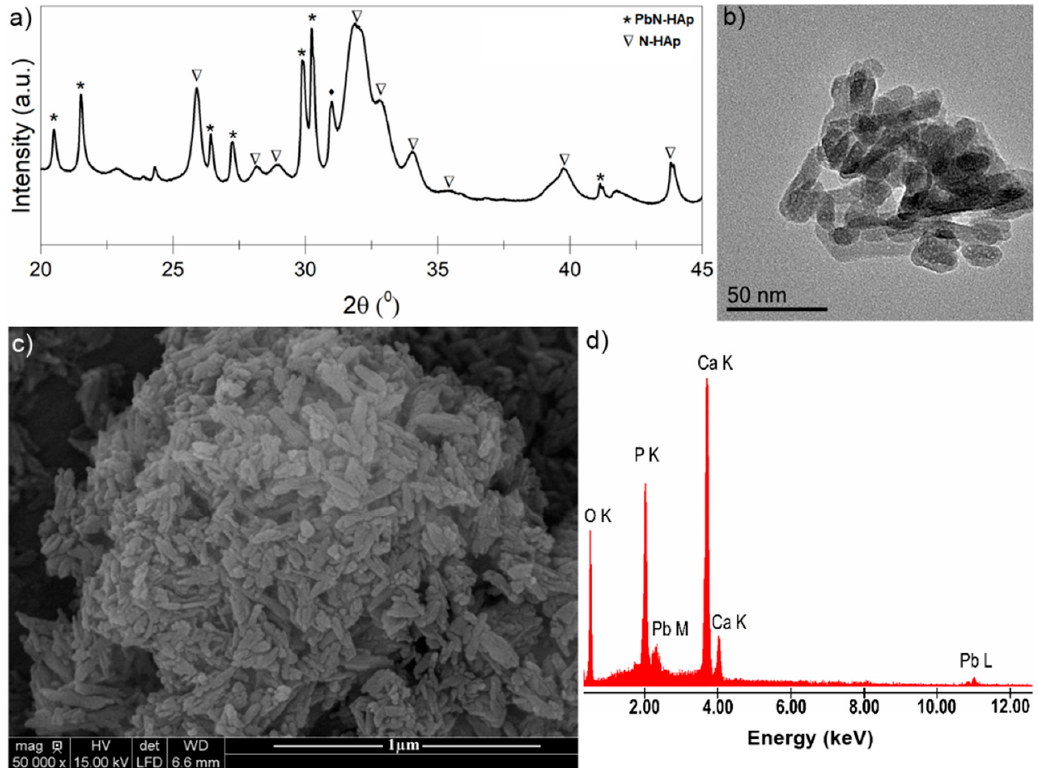
Figure 8. XRD patterns of N-HAp after lead immobilization ( a ); TEM image N-HAp after lead sorption ( b ); SEM image N-HAp after lead sorption ( c ); EDX spectra of N-HAp nanopowders ( d ).